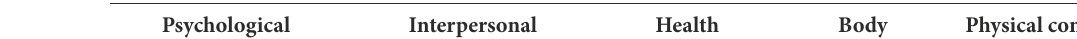
TABLE 3 Factor loading of items and factors extracted in the exploratory factor analysis of the exercise motivations inventory 2 (EMI-2) using the Brazilian test subsample ( n = 498). Factor Item Psychological Interpersonal Health Body Physical